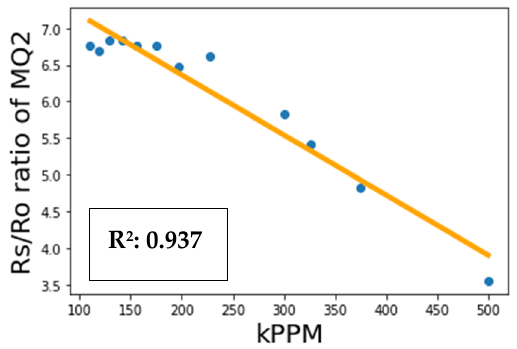
Figure 7. Calibration curve for MQ2 sensor integrated in a device.